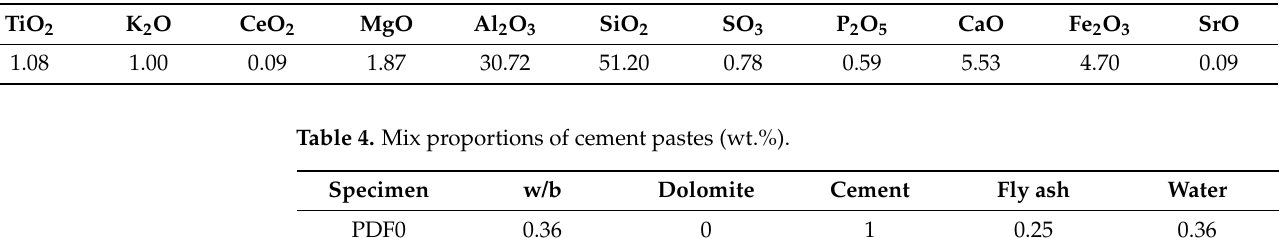
Table 3. Chemical composition of fly ash (wt.%).